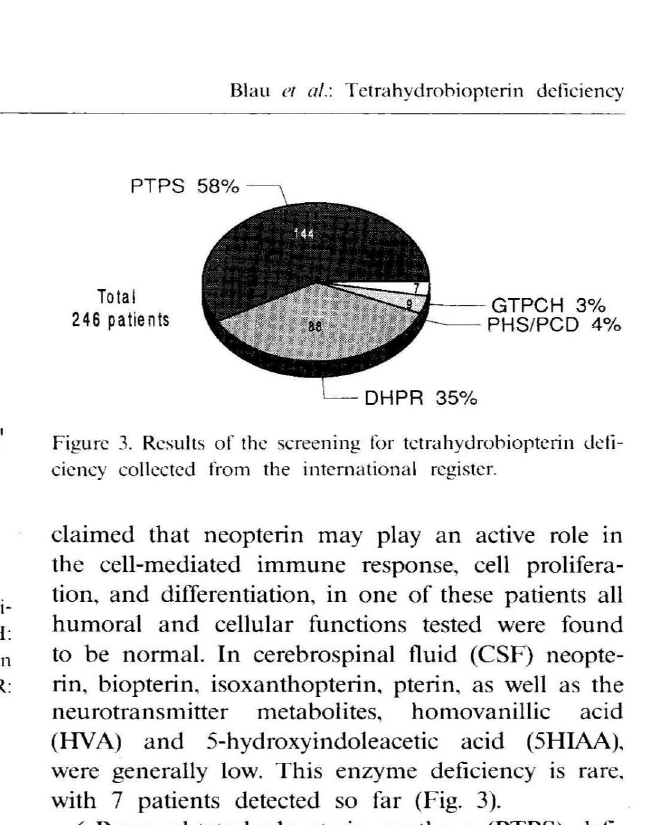
Figure l. Biosynthesis of tetrahydrohiopterin including possi hie metabolic detects in hyperphenylalaninemia (Hi' ). GTPCH: GTP cyclohydrolase I: PTPS: 6-pyruvoyl tetrahydropterin synthase: SR: sepiapterin rcductase: AR: aldose reductase: CR: carhonyl reductase.